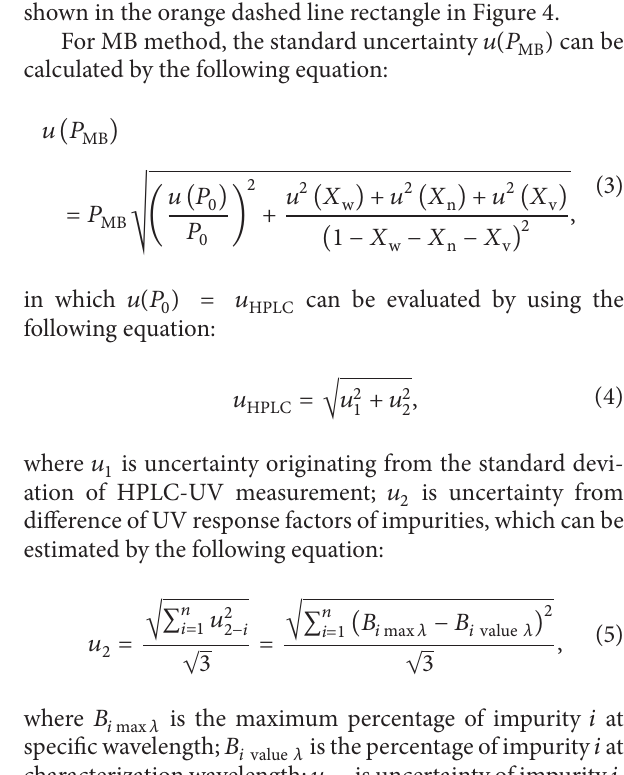
Table 6: Results of long-term stability